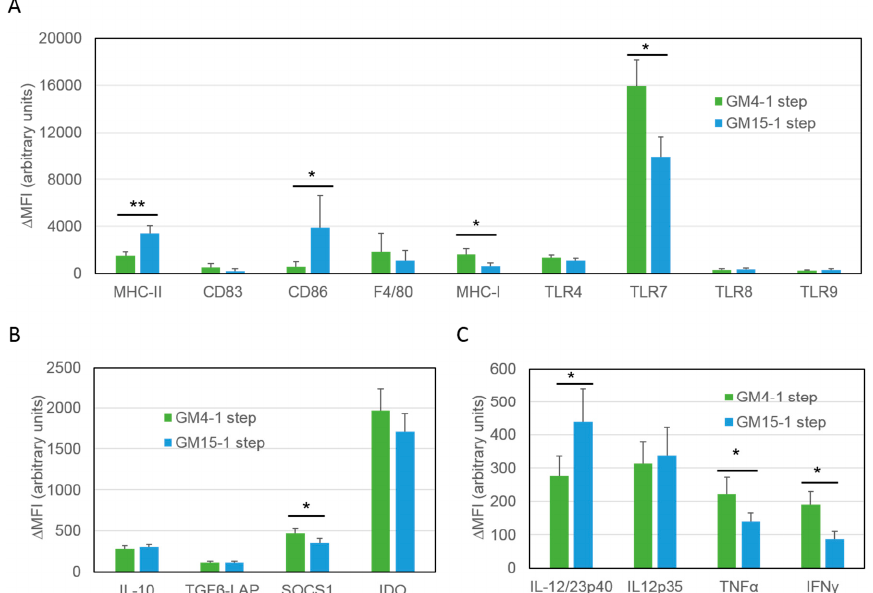
Figure 2. Phenotypic comparison between mouse DCs differentiated ex vivo from bone marrow precursors in the presence of GM-CSF and either IL-4 or IL-15. ( A – C ) Isolated mouse bone marrow cells were differentiated in vitro for 4 days in the presence of GM-CSF and either IL-4 (GM4-1 step) or IL-15 (GM15-1 step) as indicated, pulsed with an ID8 tumor cell lysate treated with squaric acid and subsequently matured with LPS/IFN γ . Expression levels of indicated markers were then assessed by antibody staining followed by FACS analysis. The net mean fluorescence intensity ( Δ MFI = Raw MFI-MFI of Isotype) for each marker is reported in the graph; data are representative of 3 independent experiments. Significant differences were assessed with unpaired Student’s t test and indicated with asterisks: * p < 0.05; ** p < 0.01. (DC: dendritic cells; GM-CSF: granulocyte-macrophage colony-stimulating factor; IL-4: interleukin-4; IL-15: interleukin-15; IFN- γ : interferon- γ ; LPS: lipopolysaccharide).